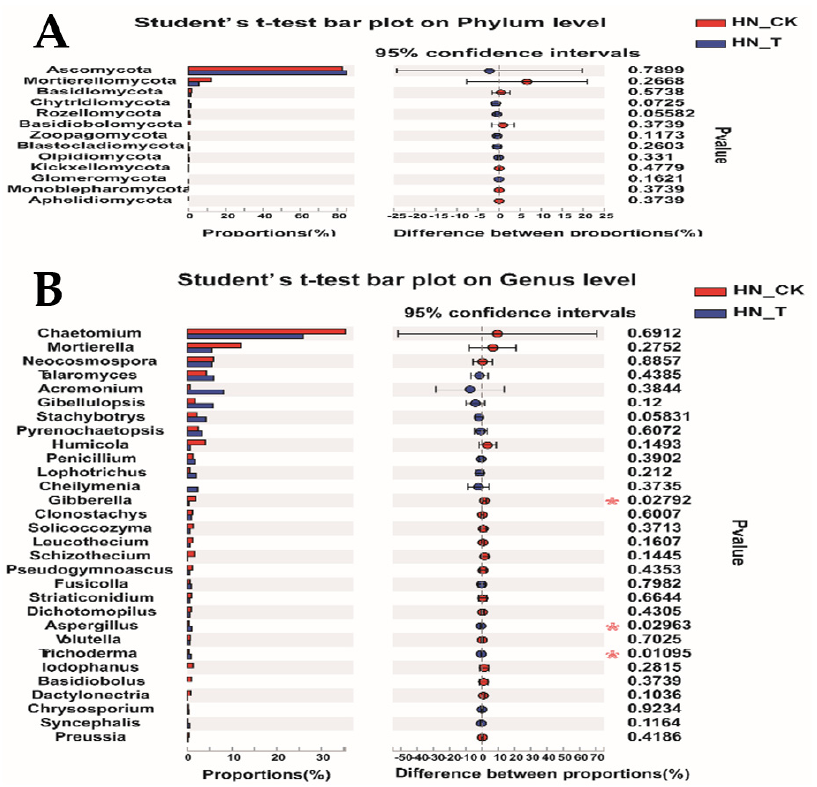
Figure 15. Changes in the relative abundance of fungal ( A ) phyla and ( B ) genera in triple-fumigated soil that had been used to produce ginger. ‘Triple fumigation’ refers to the simultaneous application of chloropicrin, dimethyl disulfide and metham sodium. The t -test reported the statistical differences (asterisked, * 0.01 < p ≤ 0.05) between the means of three replicates within the phylum or genus levels.